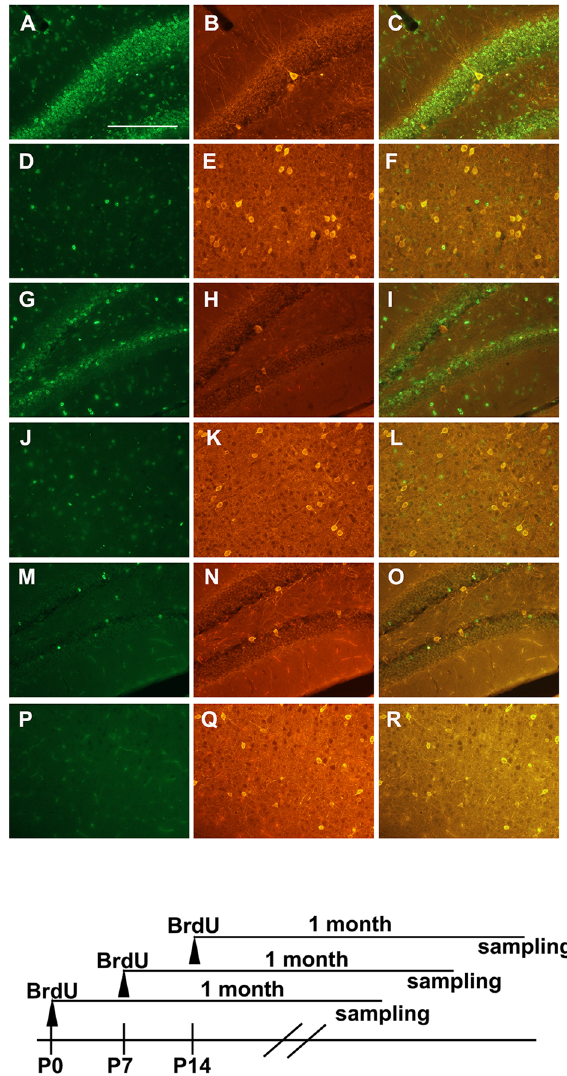
Figure 4. Validation of neurogenesis of PV neurons by BrdU pulse-chase experiment. Photomicrographs show immunostaining of BrdU (green), PV (orange), and merged image (most right panels) one month after BrdU injection. ( A – F ) Immunostaining images of the dentate gyrus of the hippocampus ( A – C ) and cerebral cortex ( D – F ) of mice injected with BrdU on PD 0. ( G – L ) Immunostaining images for the dentate gyrus of the hippocampus ( G – I ) and cerebral cortex ( J – L ) of mice injected with BrdU on PD 7. ( M – R ) Immunostaining images for the dentate gyrus of the hippocampus ( M – O ) and cerebral cortex ( P – R ) of mice injected with BrdU on PD 14. Scale bar = 200